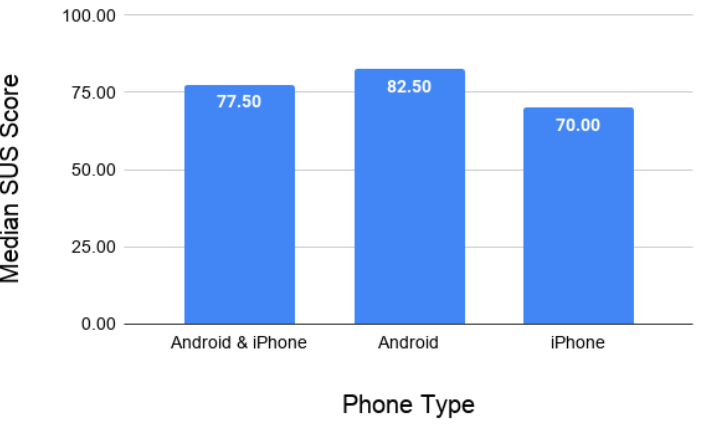
Figure 9. Median SUS scores by phone type for the first design iteration of Mission